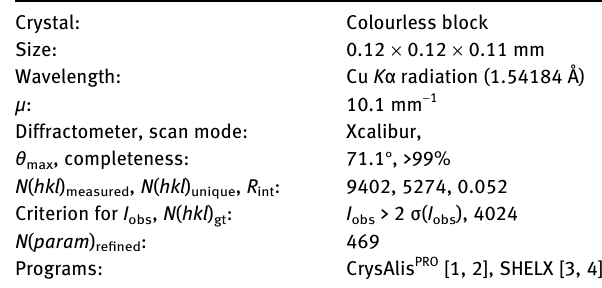
Table  : Data collection and